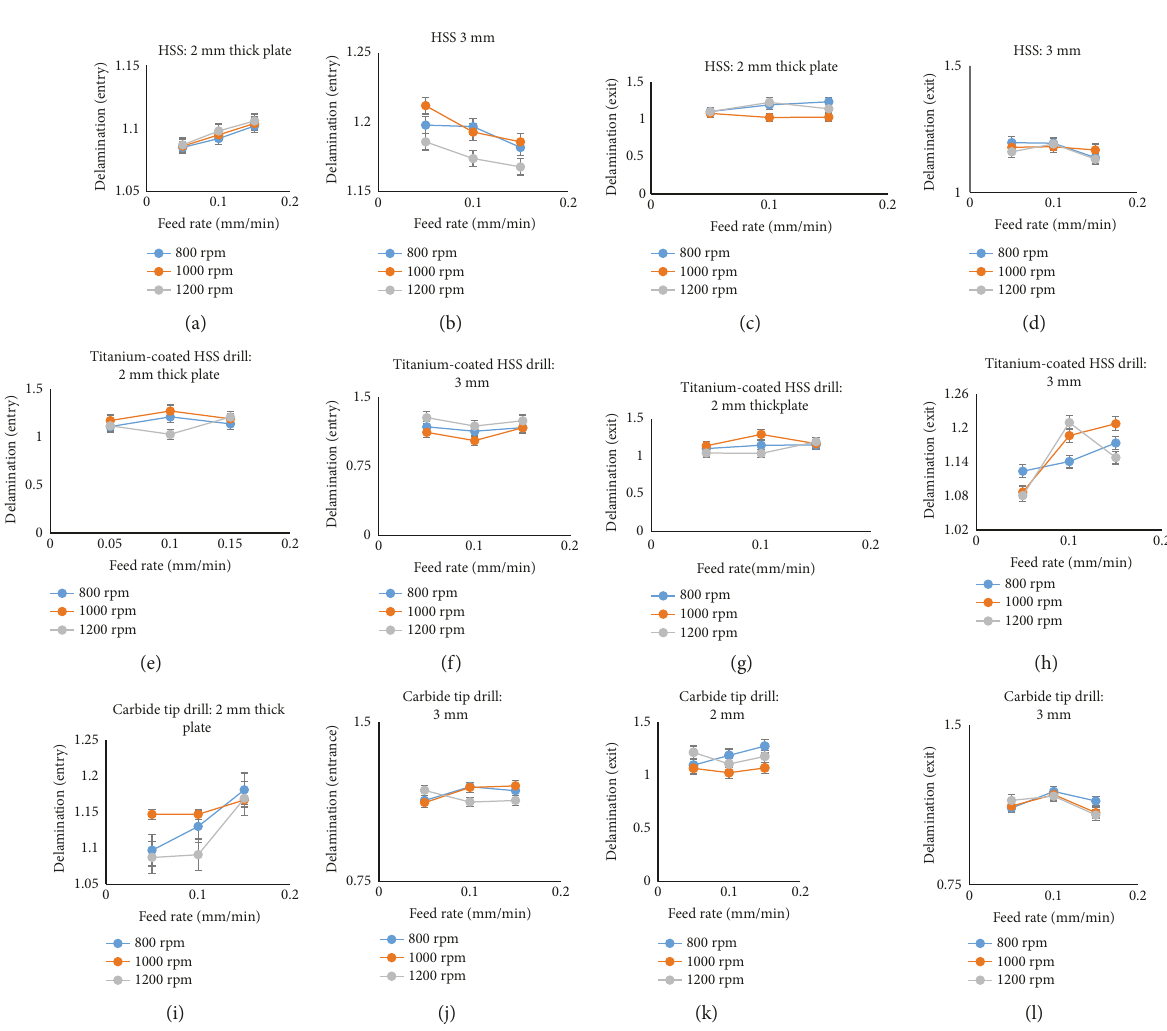
Figure 6: Delamination at entrance and exit under three di ff erent drills. (a, c, e, g, i, k) Delamination at the entry and exit of a 2 mm thickness specimen. (b, d, f, h, j, l) Delamination at the entry and exit of a 3 mm thickness specimen. (a, b) Delamination at the entrance. (c, d) Delamination at the exit. (e, f) Delamination at the entrance. (g, h) Delamination at the exit. (i, j) Delamination at the entrance. (k, l) Delamination at the exit.